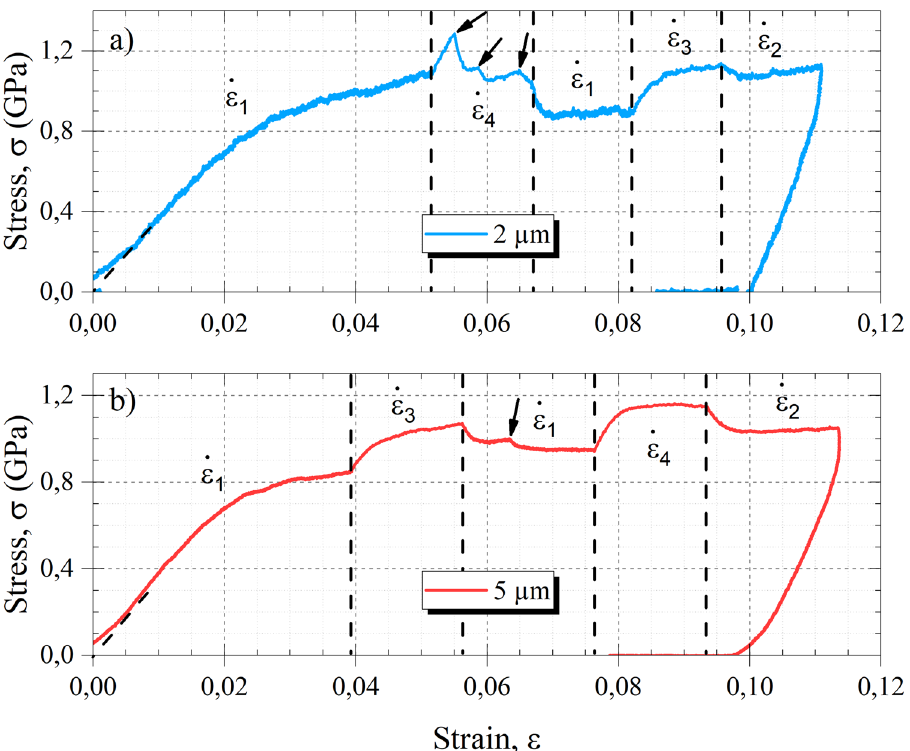
Figure 3. Stress–strain curves of InSb micro-pillars deformed with the strain rate jumps in ( a ) a diameter of 2 µm and in ( b ) 5 µm ( arrows indicate major stress drops associated to plastic